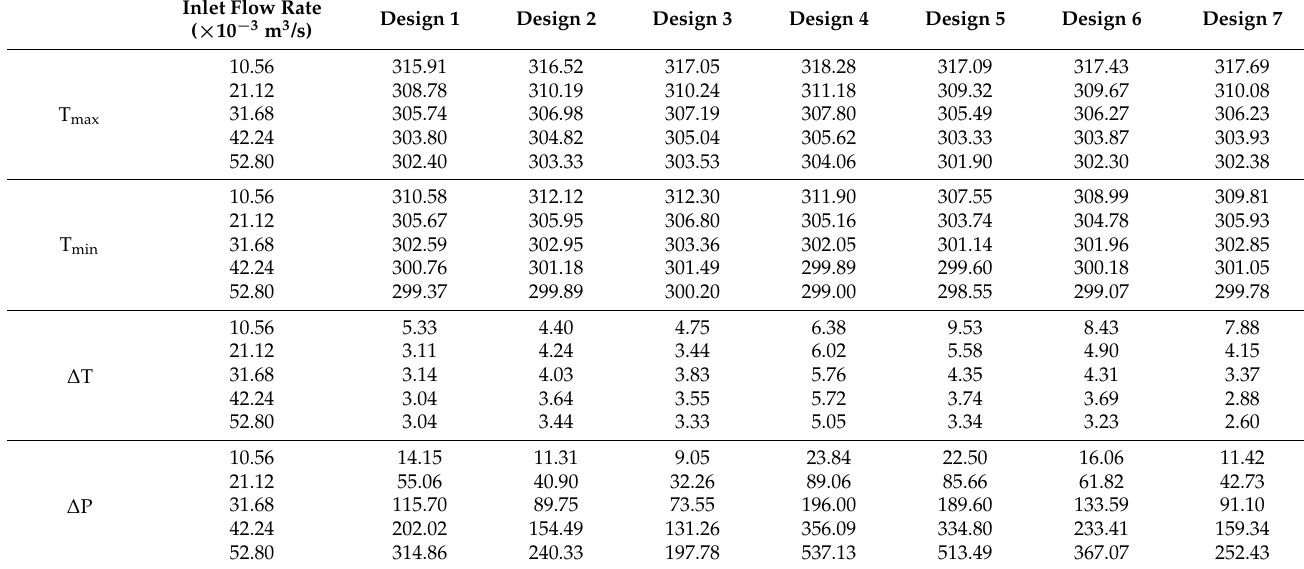
Table A1. Simulation results of 7 designs at 5 different inlet air velocities during 2C discharging. Inlet Flow Rate ( × 10 − 3 m 3